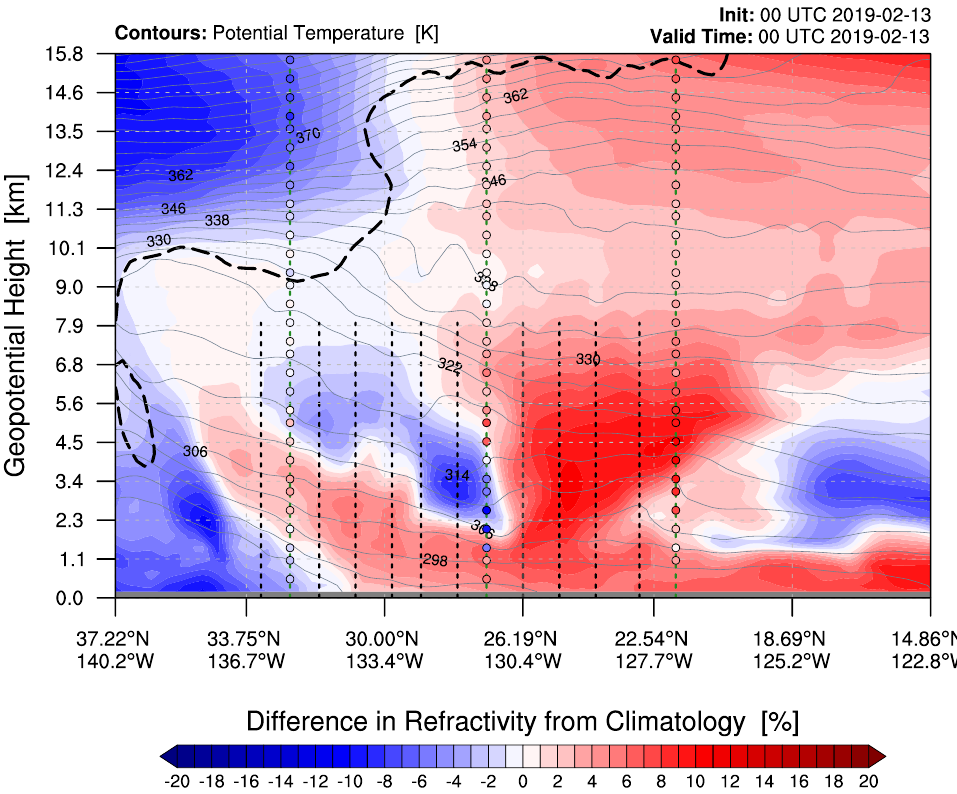
Figure 20. Cross section of the difference in refractivity (shaded, %) between the ERA5 reanalysis product and a zonal climatological profile at 27 ◦ N during February for the third intensive observing period (IOP03) of AR Recon 2019. The cross section follows the easternmost dropsonde transect through the atmospheric river shown in Figures 18 and 19. Potential temperature (grey contours, K) and the 2 PVU contour representing the dynamic tropopause (thick black dashed line) are overlain. The location of the dropsondes along this transect (see Figure 19) are indicated by black dashed vertical lines. The refractivity from the paired occultations is overlain on the lines indicating the dropsonde profiles using filled circles every 0.5 km in the vertical along the given profile. The difference in refractivty between the occultations and the same climatological profile is indicated using the same color scale to fill the circles as was used for the shaded